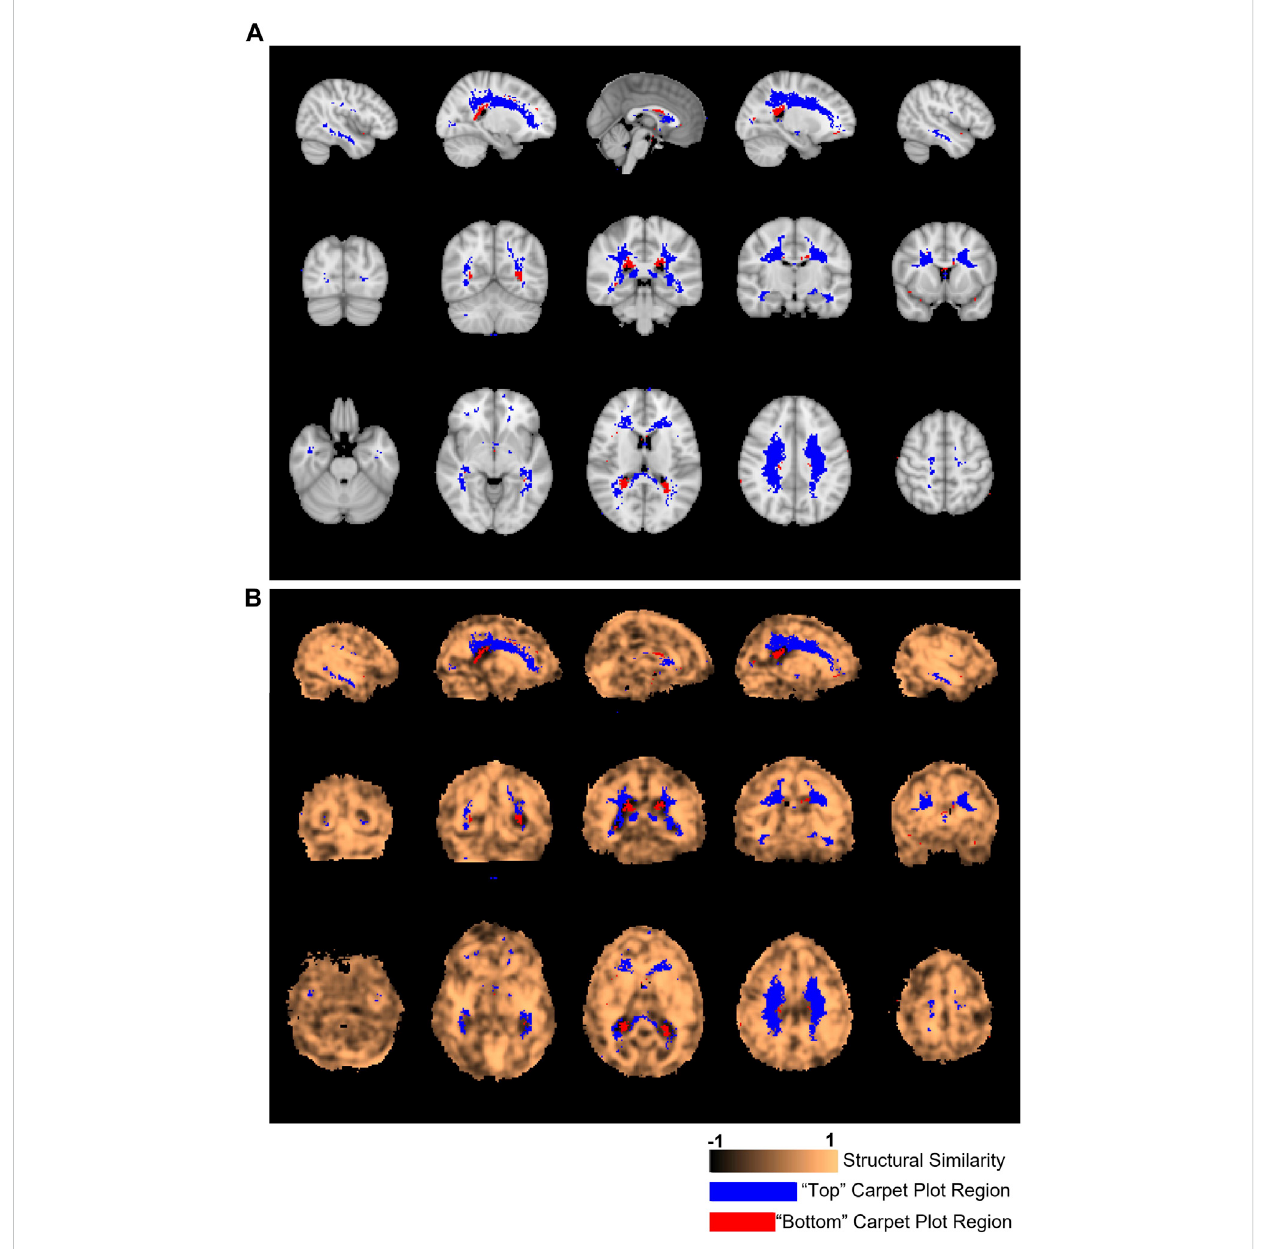
FIGURE 6 Locations of voxels located in top and bottom carpet plot regions and correspondence with structural similarity map. (A) Colored voxels indicate locations corresponding to voxels which were located in the top and bottom regions of CO 2 carpet plots in at least half of all subjects. Blue voxels correspond to those cropped from the top of the carpet plot (with extra long CO 2 -derived delay times), while red voxels correspond to those cropped from the bottom of the carpet plot (with extra short CO 2 -derived delay times). (B) The same cropped carpet plot voxels from (A) are overlaid on the structural similarity value map comparing the subject-averaged DSC-TTP delay map with the subject-averaged CO 2 -arrival delay